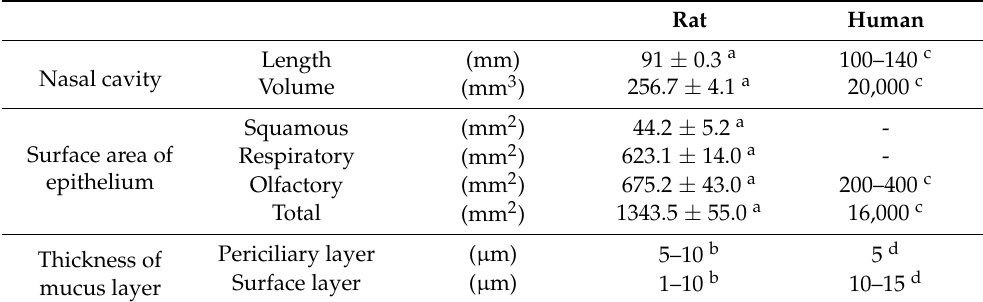
Table 2. Morphological differences between the nasal cavity and mucus in rat and